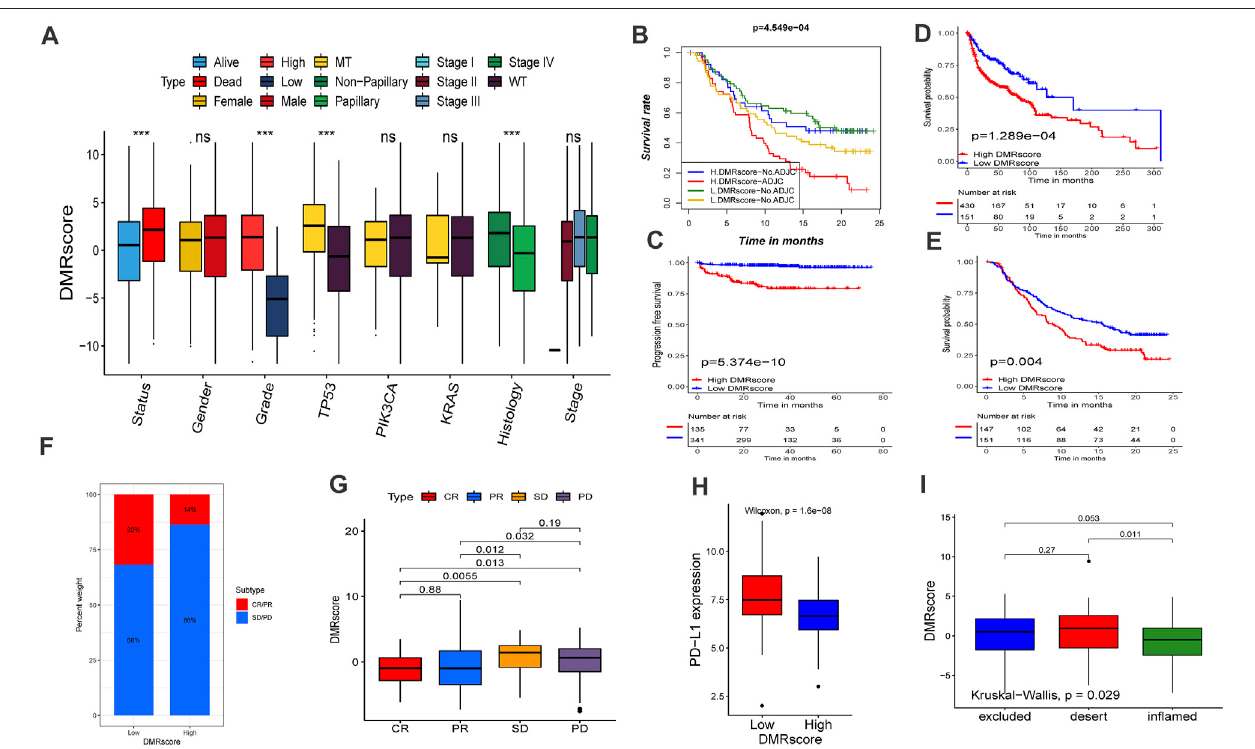
FIGURE6| RoleofDNAmethylationmodi fi cationinclinicalprediction. (A) DifferencesinDMRscoreamongdifferentclinicalstatus.Themedianvalue:blacklines in boxes, the outliers: black dots out boxes. MT, mutation type; WT, wild type. (B) Kaplan-Meier curve showed the clinical prognosis of patients with combination of DMRscore and NEO strati fi cation. H, high. L, low. NEO, Newantigen burden ( p < 0.001). (C) Survival analyses for high (135 samples) and low (341 samples) DMRscore subgroups in the E-MTAB-4321 cohort using Kaplan-Meier curves ( p < 0.001). (D) Survival analyses for high (430 samples) and low (151 samples) DMRscore subgroups in the GEO-metacohort cohort using Kaplan-Meier curves ( p < 0.001). (E) Survival analyses for high (147 samples) and low (151 samples) DMRscore subgroups in the anti-PD-L1 cohort (IMvigor210 cohort) using Kaplan-Meier curves ( p (cid:1) 0.004). (F,G) The proportion of patients with response to PD-L1 blockade immunotherapy in low or high DMRscore subgroups. SD, stable disease; PD, progressive disease; CR, complete response; PR, partial response. Responser/ Nonresponer:32%/68% inthelow m6Ascore groupsand 14%/86% inthe high m6Ascore groups. HDifferences in PD-L1 expression betweenlowand high m6Ascore groups ( p < 0.0001). L Differences in DMRscore among distinct tumor immune phenotypes in IMvigor210 cohort. ( p (cid:1) 0.029).